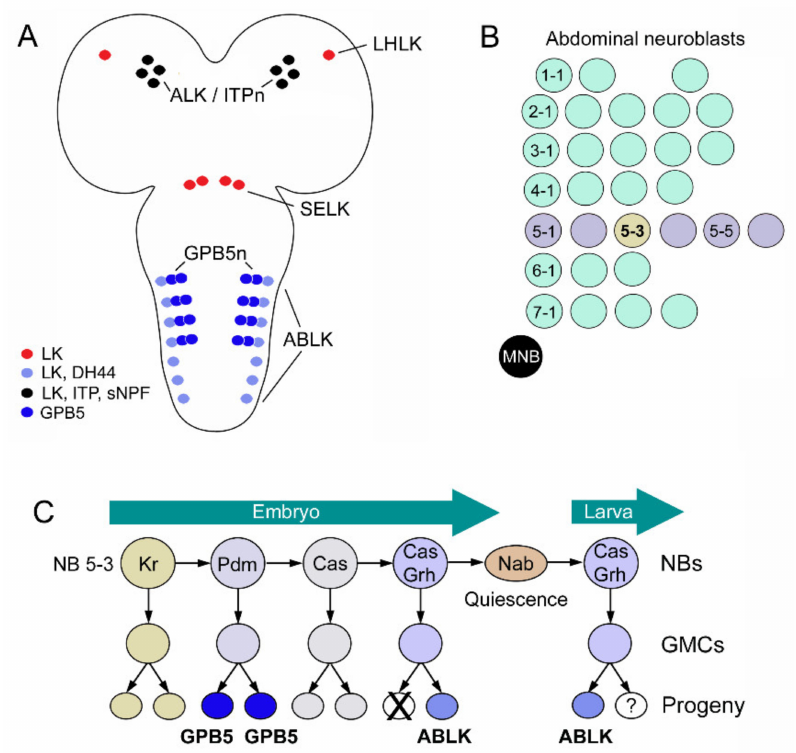
Figure 13. Lineages of LK and GPB5 neurons during development. ( A ) Larval CNS with cell bodies of LK neurons (ALK/ITPn; LHLK, SELK and ABLK) and the peptides expressed in these cells (colored circles). In the first four abdominal neuromeres, there are also neurons expressing the glycoprotein GPB5 (two pairs in each neuromere). ( B ) Neuroblasts in one abdominal hemi-neuromere with rows numbered from 1 to 7. Neuroblast 5-3 gives rise to ABLKs and GPB5 neurons. MNB, median neuroblast. ( C ) Origins of GPB5 neurons and ABLKs from neuroblast 5-3 during embryonic and larval development. Transcription factors: Kr, Krüppel; Pdm, Nubbin/Pdm2; Cas, Castor; Grh, Grainy head; Nab, transcriptional cofactor. This figure (C) was redrawn from